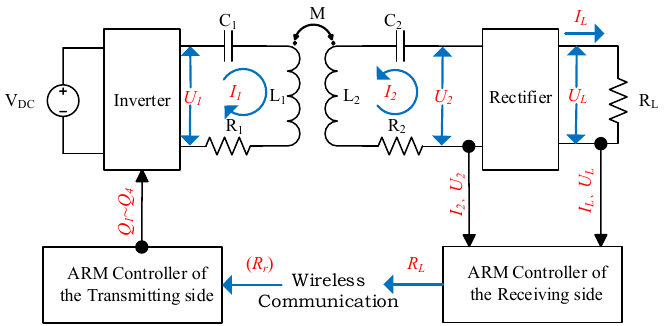
Figure 4. The closed-loop control structure of WPT system with CC/CV output.